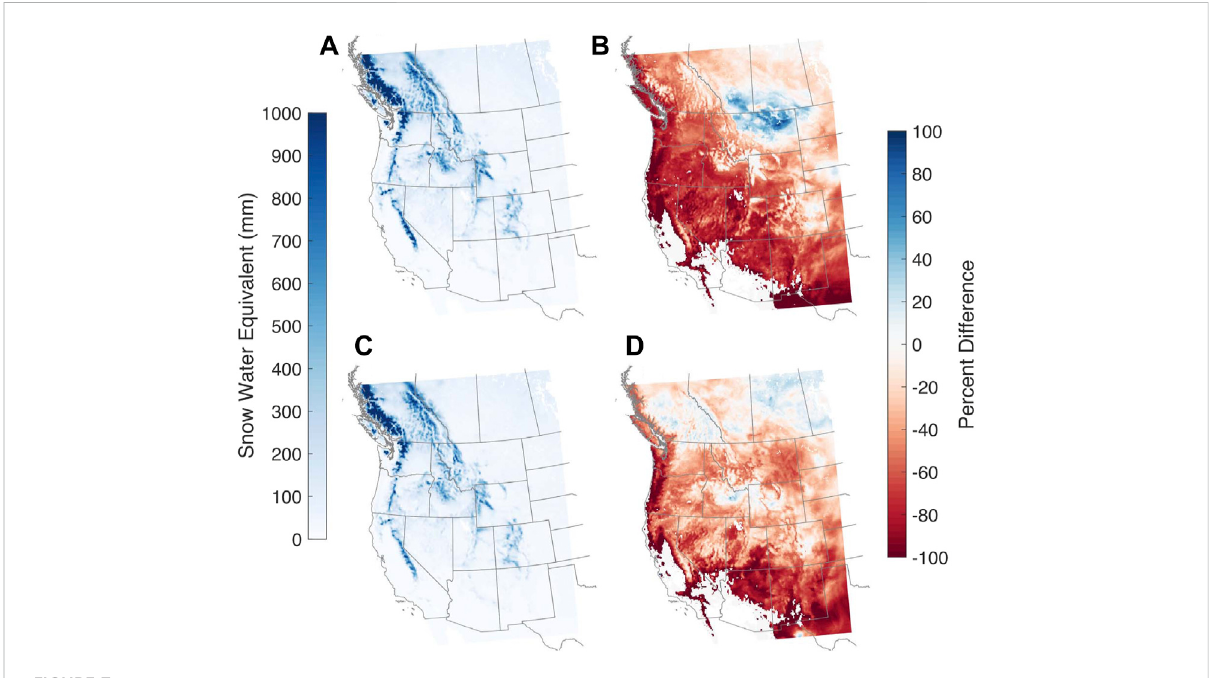
FIGURE 7 As for Figure 4 but for grid-cell peak SWE. (A,B) are for WRF/CCSM and (C,D) are for WRF/NorESM.